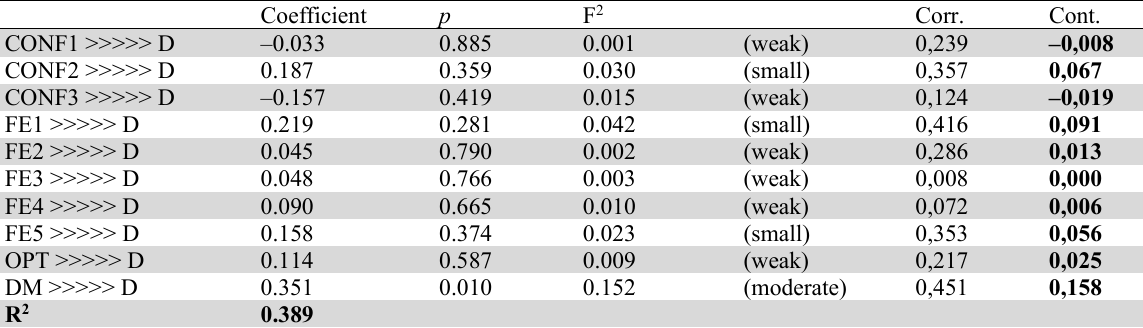
Path Coefficient, R 2 , p, and F 2 (Model IIa)